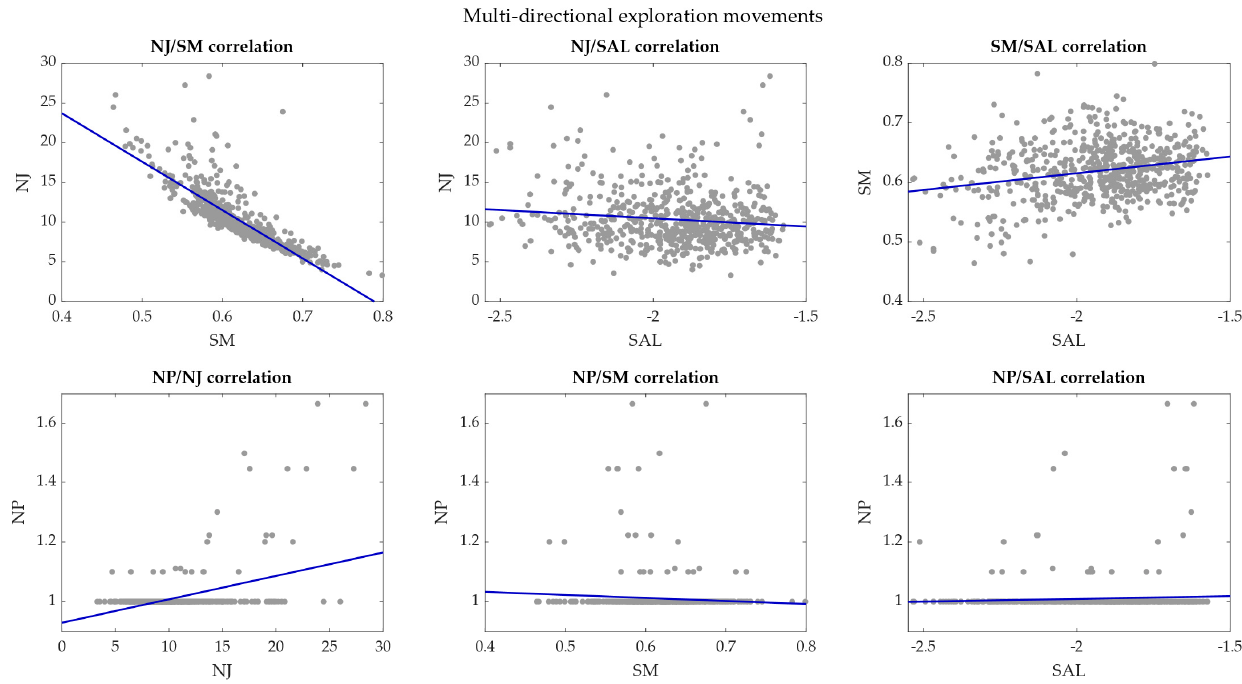
Figure 10. Correlation plot between smoothness metrics—EXP movements. The correlations be- tween pairs of smoothness metrics are reported in each plot and the regression lines are marked in blue.